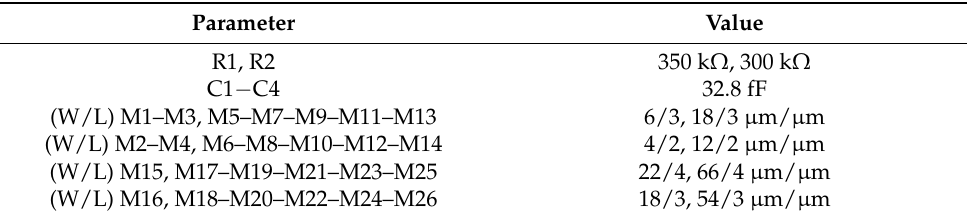
Table 1. Design parameters for ring oscillator.